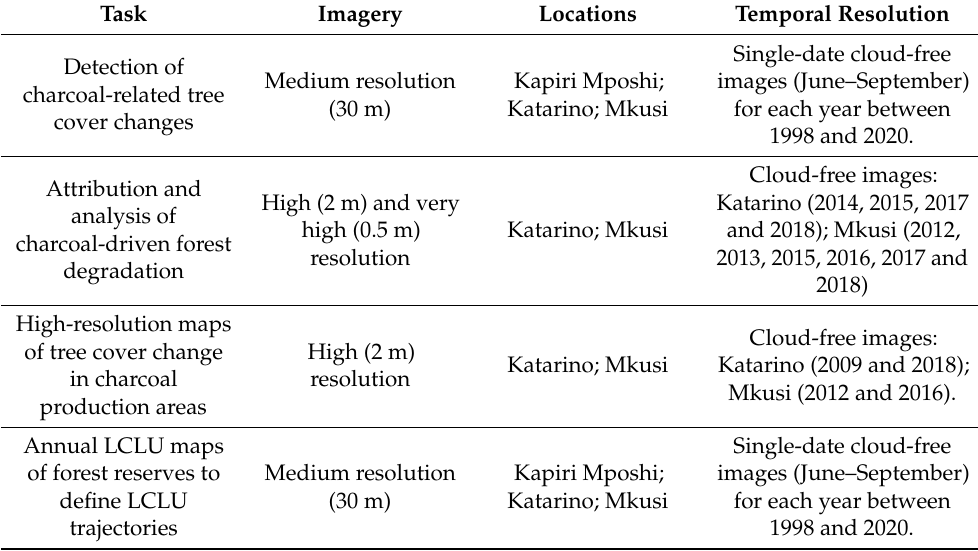
Figure 2. Seasonal NDVI profiles for main land cover land use classes in forest reserves. Forest NDVI profile shows a gradual decline as the dry season progresses. The values of the shrub NDVI profiles present a greater drop during the dry season. The agricultural NDVI profile shows a prolonged decline starting from harvest and the dry season, followed by a rapid recovery with the onset of the rains. The September–November acquisition window maximizes the spectral separability between the three classes. Table 1. Basic information on implemented tasks, imagery used and sites where they were